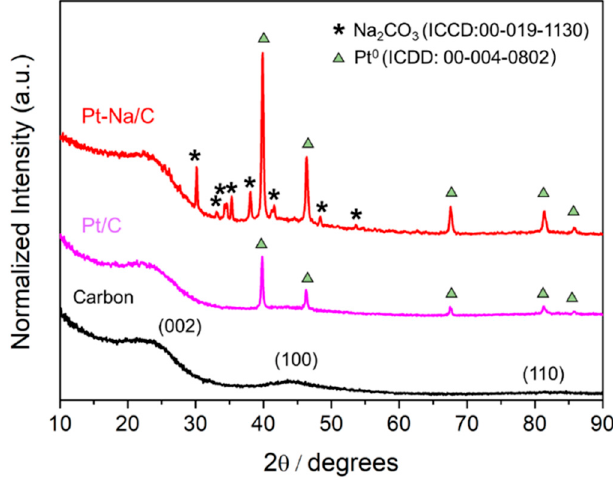
Figure 1. XRD patterns of the support and the prepared catalysts.